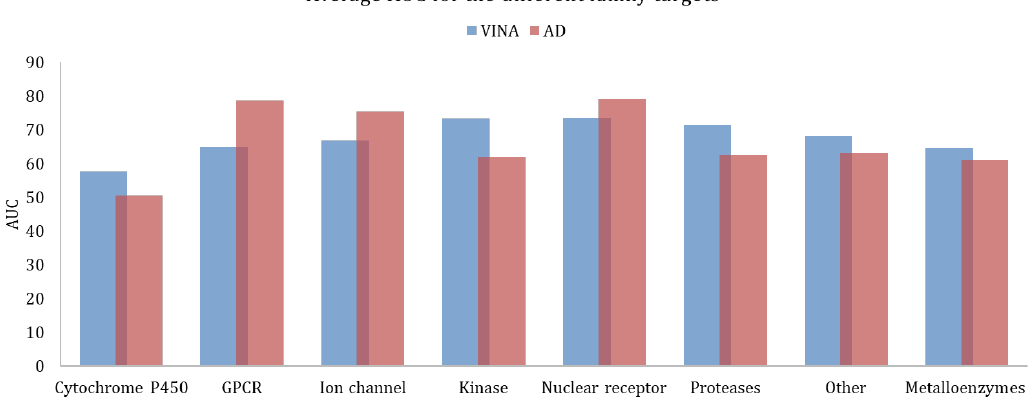
Figure 3. Average AUC calculated for the different family targets, obtained with Vina and AutoDock.